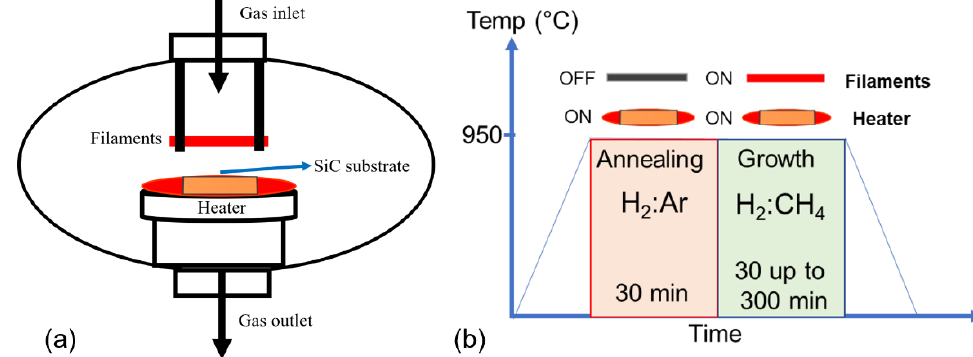
Figure 1. Hot filament chemical vapor deposition (HFCVD) reactor and graphene growth process, ( a ) schematic and ( b ) graphene growth steps on the